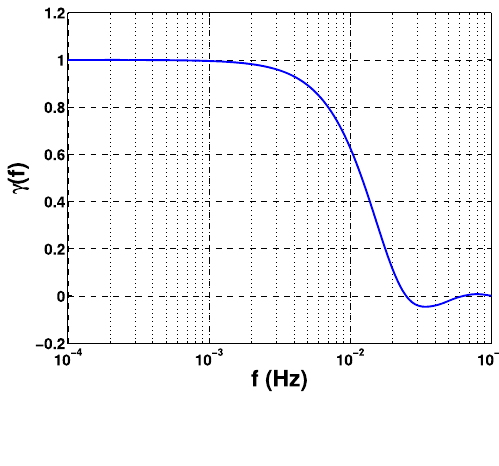
Fig. 36 Plot of the normalized overlap function for strain response for the hexagram configuration shown in Fig.